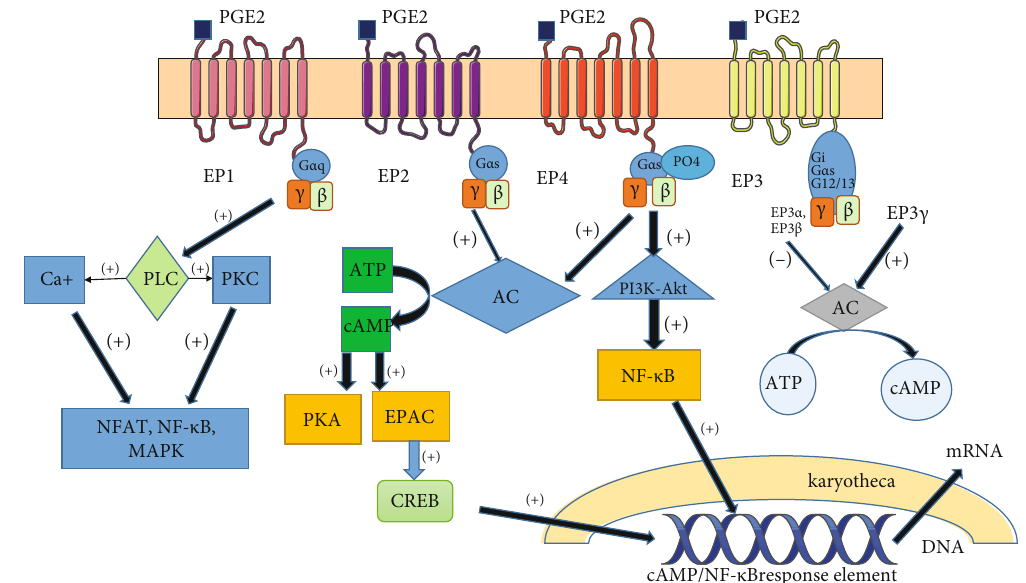
Figure 2: The signaling pathway of PGE . The schematic diagram shows the downstream signaling pathway of PGE 2 actives or inhibits the target cell via four EP receptors, EP1, EP2, EP3, and EP4. Di ff erent receptors activate di ff erent signaling pathways which are connected in a network in the cell and cooperate with each other in vital